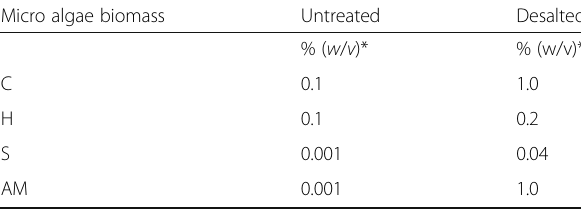
Table 1 Preparation of non-toxic extracts from micro algae biomass Micro algae